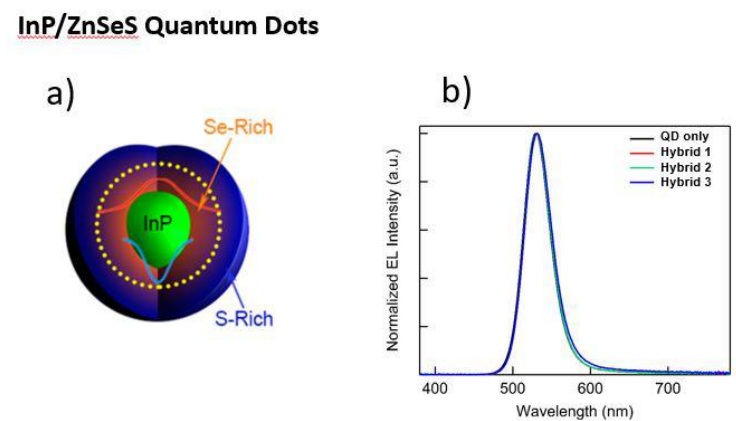
Figure 14. Structure of InP QDs coated with a ZnSeS shell ( a ) as well as the electroluminescence of QLEDs ( b ) prepared from such QDs after coating with a semiconducting polymer (a block copolymer from M2 in Figure 12).